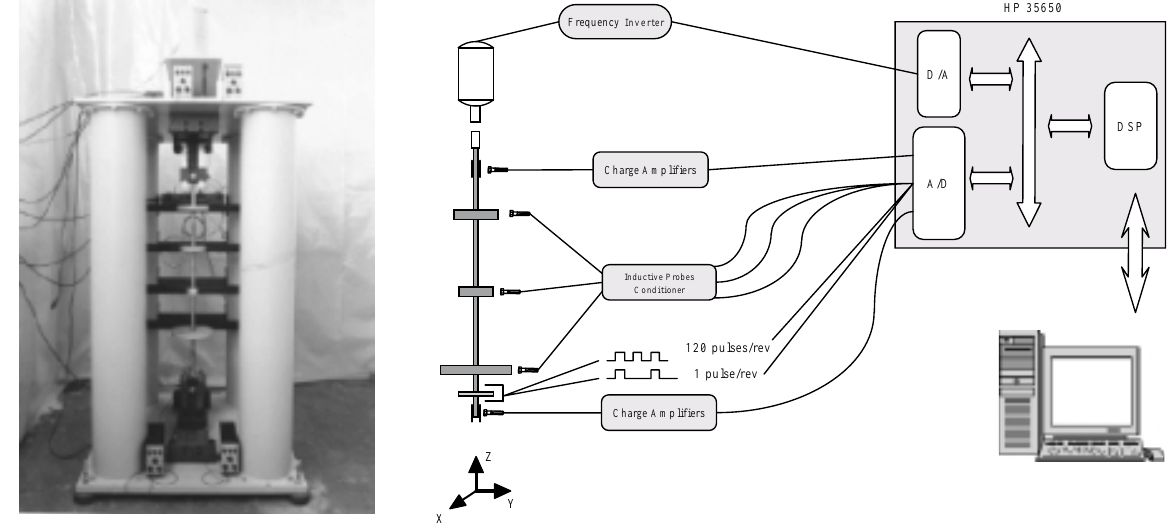
Fig. 1. Experimental